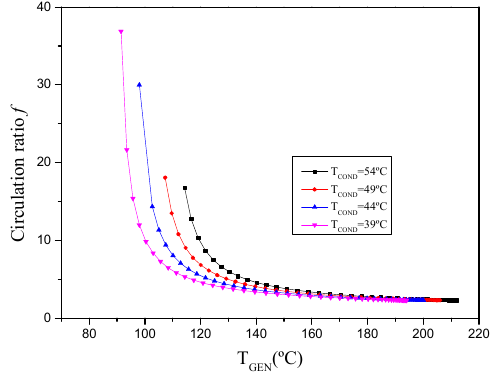
Figure 8. f of the basic cycle versus T GEN at different T COND .